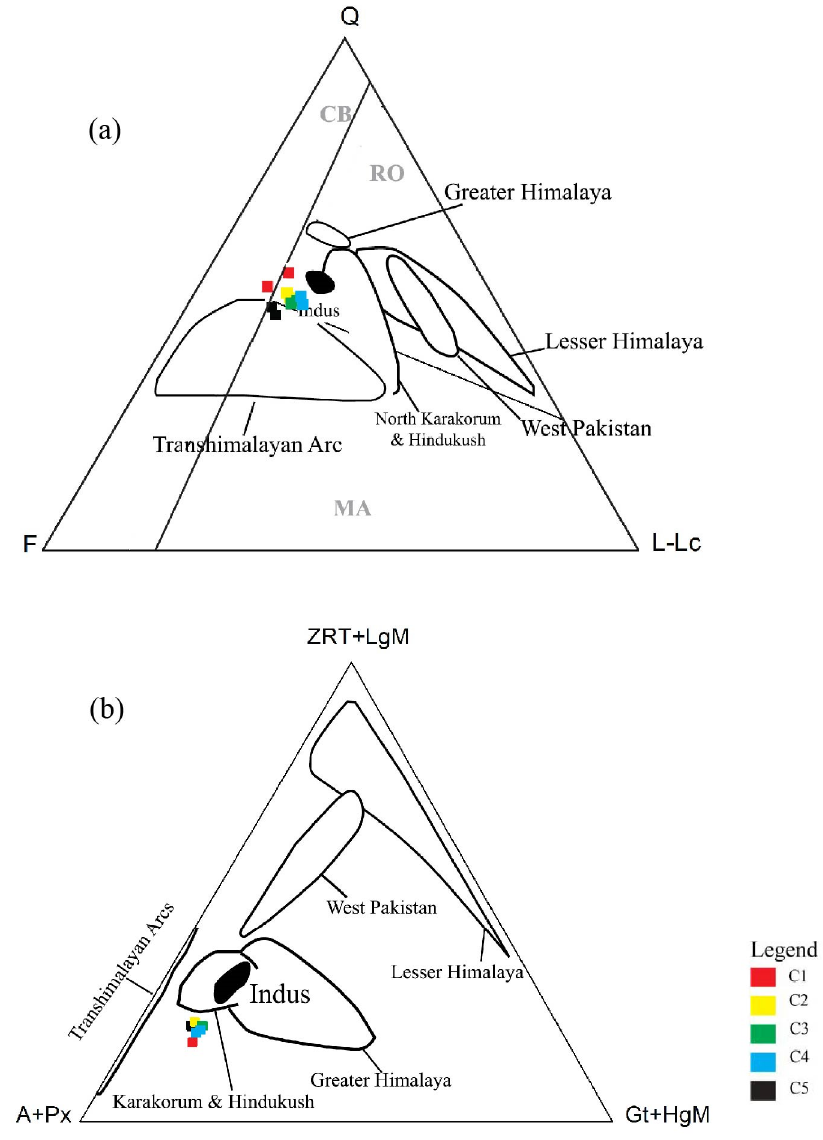
Figure 10. The triangular plots show ( a ) petrography, Q = quartz, F = feldspar, L-Lc = lithic-lithics carbonates and ( b ) heavy-mineral assemblages, ZRT + LgM = ultrastable minerals zircon tourmaline rutile + low grade minerals mostly epidote group minerals, A + Px = amphibole + pyroxene, Gt + HgM = garnet + high-grade minerals mainly sphene, carried by the Indus River plot near the boundary between recycled orogen (RO), magmatic arc (MA), and continental block (CB) provenance fields [44] .